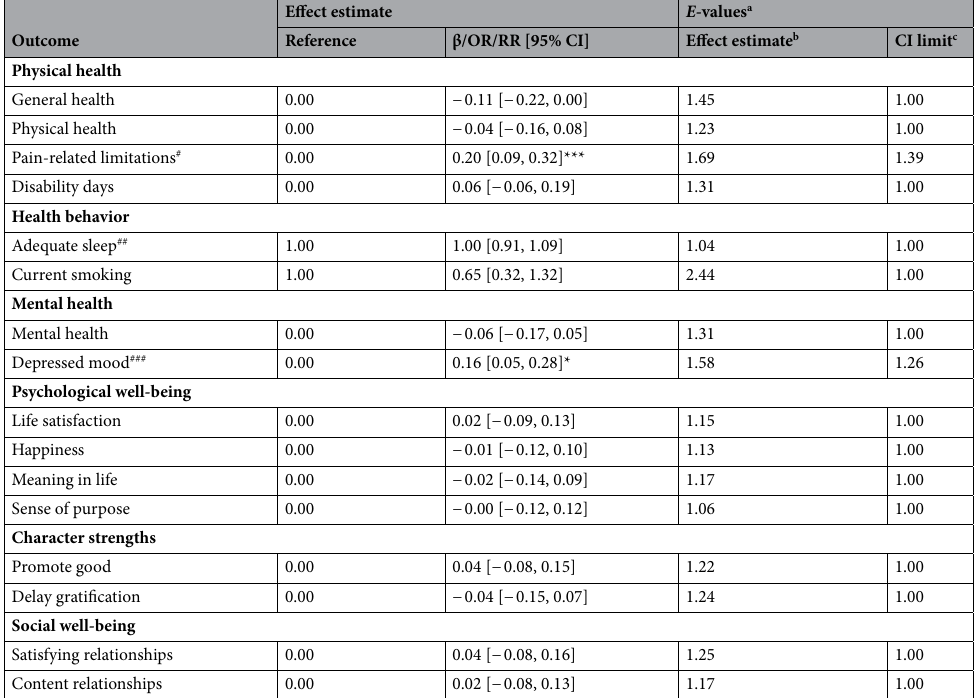
Table 2. Associations of overall suffering (T1) with health and well-being outcomes (T2) in Study 1 (factory worker sample). β standardized effect size, CI confidence interval, OR odds ratio, RR risk ratio. n = 344 for all analyses. Multiple imputation was performed to impute missing data on the exposure, covariates, and outcomes. We ran a different type of model depending on the nature of the outcome: (1) for each continuous outcome, we ran a linear regression model to estimate a β; (2) for the outcome of current smoking (prevalence of < 10%), we ran a logistic regression model to estimate an OR; (3) for the outcome of adequate sleep (prevalence of ≥ 10%), we ran a generalized linear model with a log link and Poisson distribution to estimate a RR. If the reference value is “0,” the effect estimate is β; if the reference value is “1,” the effect estimate is OR or RR. Each continuous outcome was standardized ( M = 0, SD = 1). All models adjusted for prior values of age, gender, ethnic status, marital status, educational attainment, job tenure, child dependents, and older adult dependents assessed at T1. Unless otherwise indicated, all models also adjusted for the prior value of the respective outcome assessed at T1. If a prior value of an outcome was not available, we adjusted for the prior value of a variable that was most comparable to the outcome: # pain-related limitations days, ## sleepless days, ### depressed mood days (see Supplemental Table S2). *p < 0.05 before Bonferroni correction, *** p < 0.05 after Bonferroni correction (the p -value cutoff for Bonferroni correction was 0.05/16 = 0.003 for each outcome). a The formula for calculating E -values can be found in VanderWeele and Ding 47 . b E -values for effect estimates are the minimum strength of association that an unmeasured confounder would need to have with both the exposure and the outcome variable to fully explain away the observed effect, after accounting for the measured covariates. c E -values for the limit of the 95% CI closest to the null denote the minimum strength of association that an unmeasured confounder would need to have with both the exposure and the outcome variable to shift the confidence interval to include the null value, after accounting for the measured